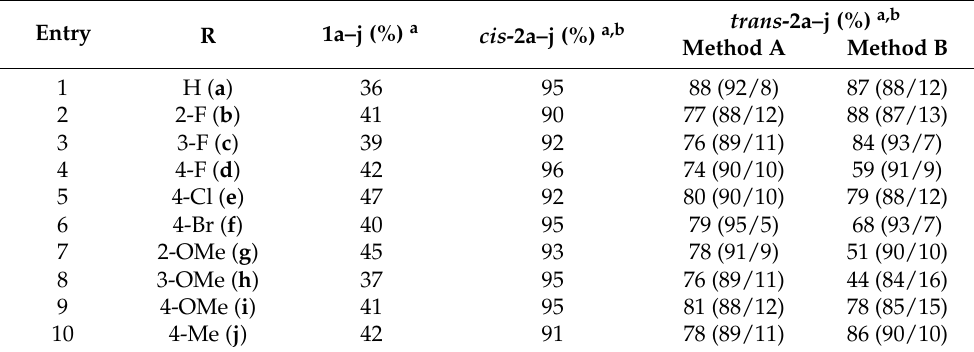
Table 2. Non stereoselective chemical synthesis of flavanones 1a – j , cis - and trans -alcohols 2a – j